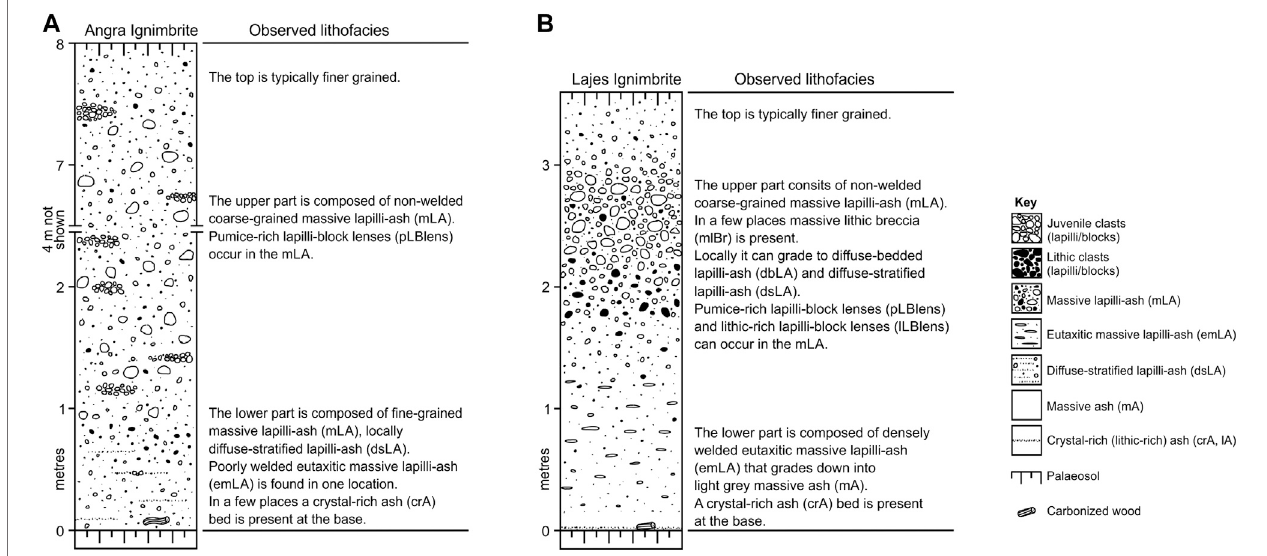
FIGURE 6 | Generalized stratigraphic sections of the Angra Ignimbrite (A) and the Lajes Ignimbrite (B) , with description of the observed lithofacies.